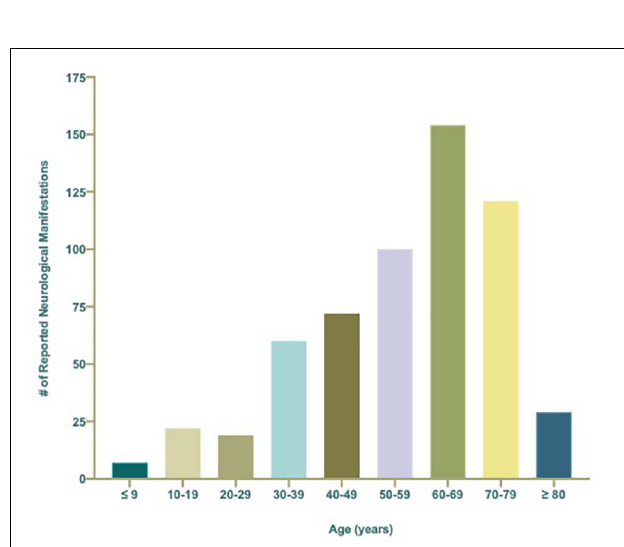
FIGURE 4 | Total number ( n = 584) of reported neurological manifestations occurring in patients with COVID-19 per decade ranging from ≤ 9 to ≥ 80 years of